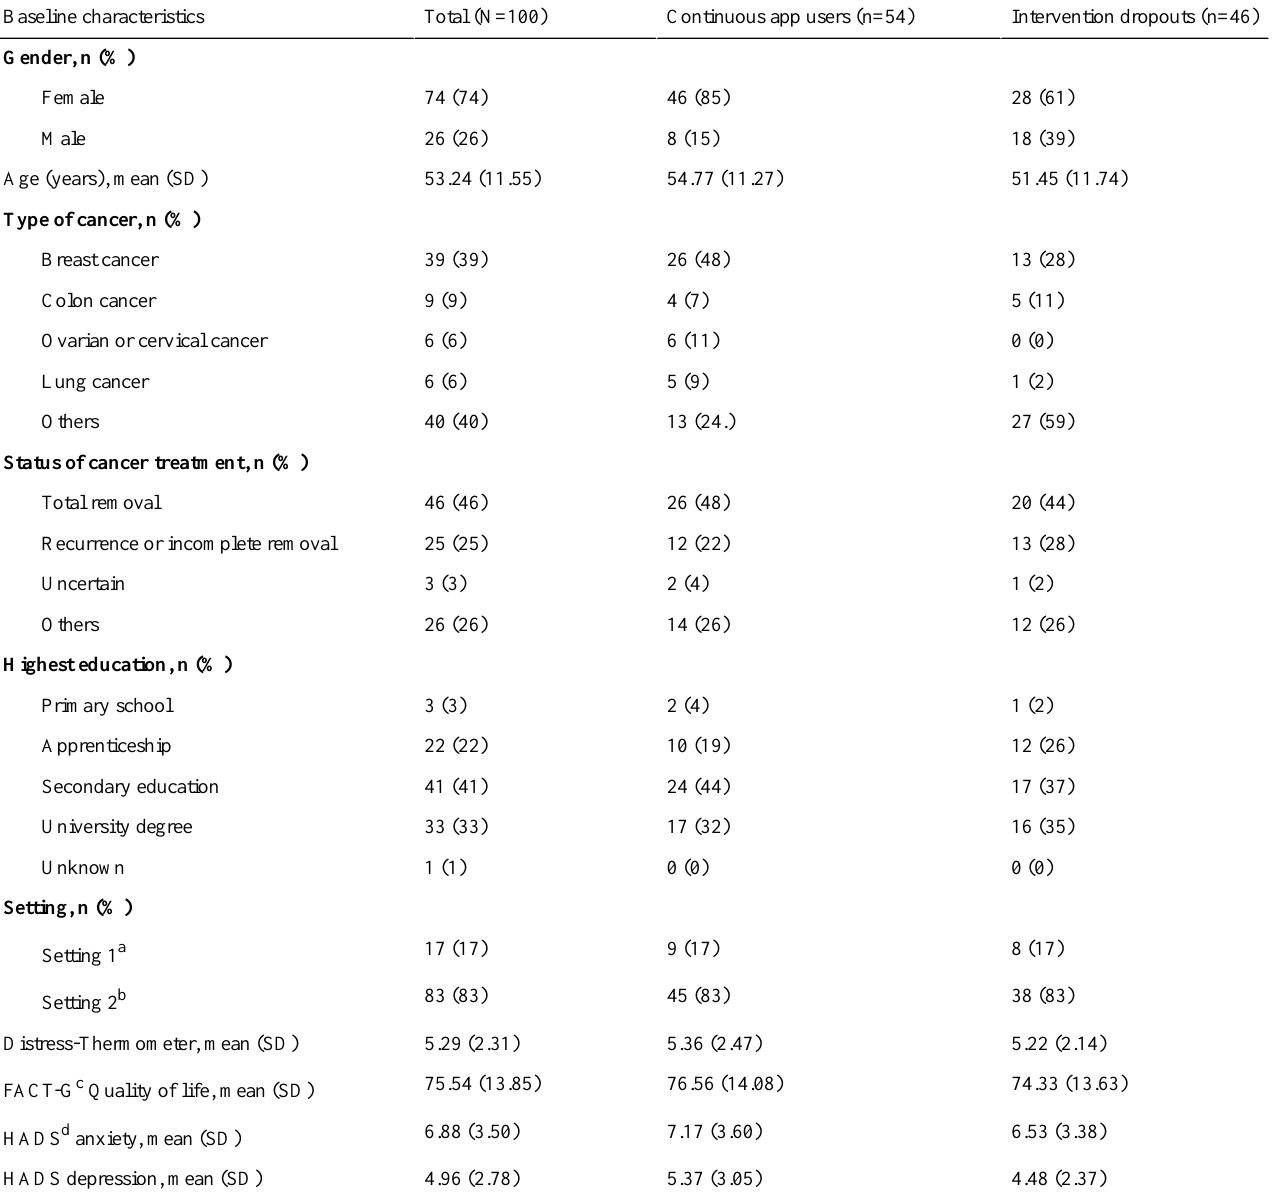
Table 1. Baseline characteristics of all enrolled patients, continuous app users, and intervention dropouts.